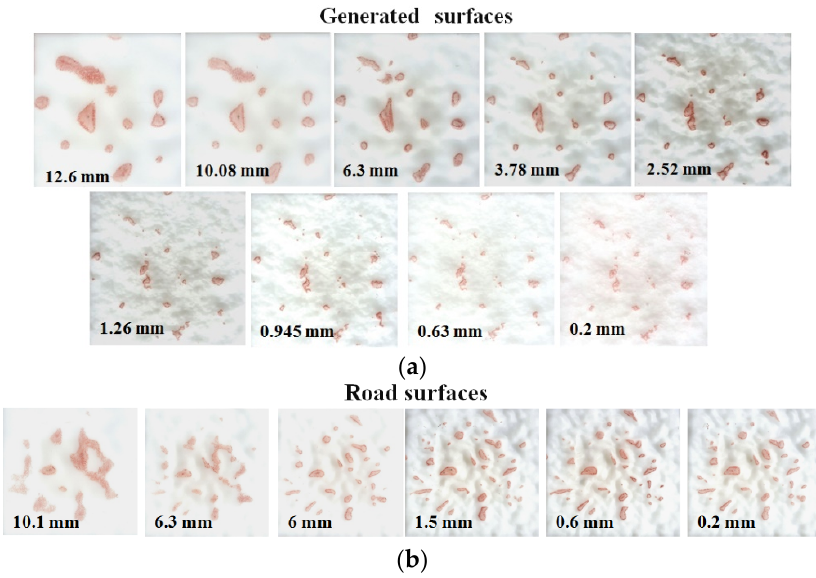
Figure 5. Observed contact area on ( a ) artificially generated surfaces and ( b ) AC pavement surfaces.